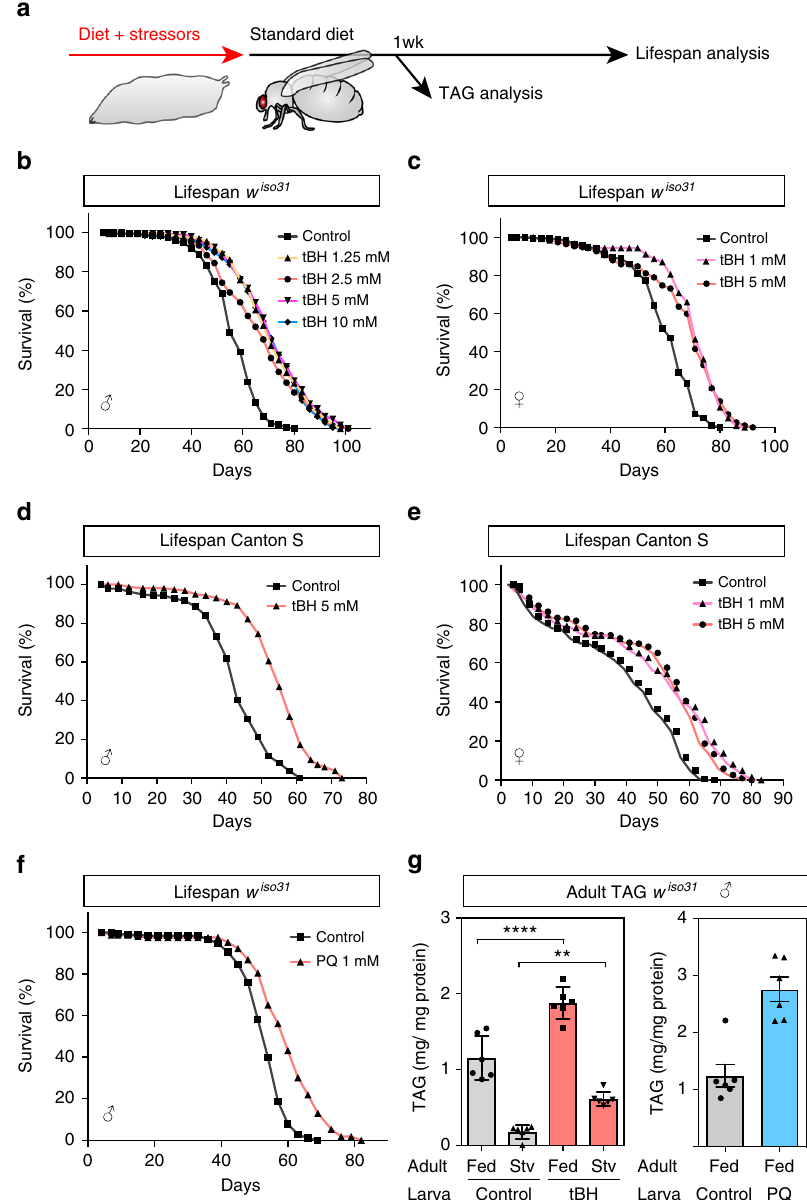
Fig. 1 Low-dose oxidants during development increase adult fat storage and longevity. a Outline of experimental strategy. b – e Lifespan of w iso31 male ( b , d ) or female ( c , e ) fl ies, raised on 1 – 20 mM tBH. f Lifespan of w iso31 male fl ies raised on 1 mM paraquat. g Whole-body triacylglycerol (TAG) amount in w iso31 male fl ies of 1 week of age, with or without starvation for 24 h. Mean ± SEM ( n = 6). ** p < 0.01 and **** p < 0.0001, see Methods for details of statistical tests used in this and all subsequent fi gures. Statistics for survival (lifespan) curves are summarised in Supplementary Table